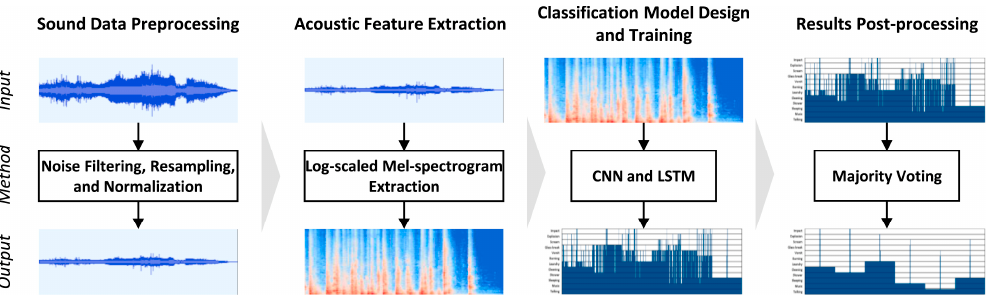
Figure 9. The research process for sound recognition-based emergency event detection [107].